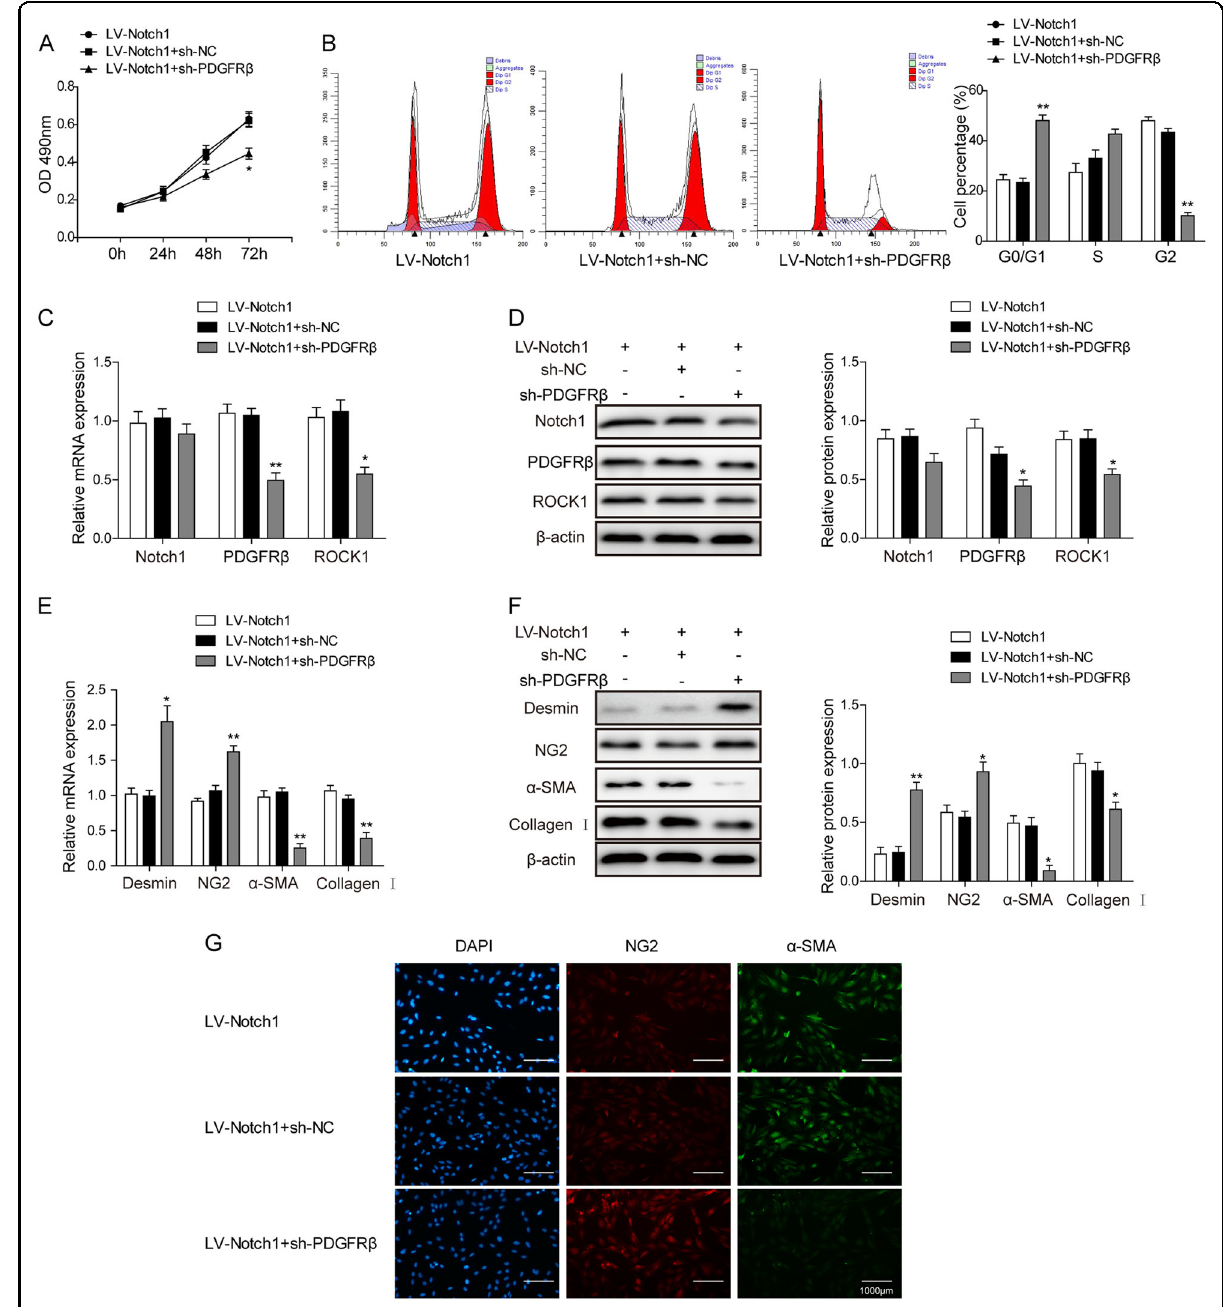
Fig. 3 PDGFR is involved in Notch1-mediated pericyte behaviors. a The MTT assay for cell viability after PDGFR β knockdown in LV-Notch1 cells (LV-Notch1 + sh-PDGFR β ) compared with that of the LV-Notch1 + sh-NC and LV-Notch1 groups. b Flow cytometry for cell cycle analysis of pericytes from LV-Notch1, LV-Notch1 + sh-NC, and LV-Notch1 + sh-PDGFR β groups. c Relative mRNA expression of Notch1, PDGFR β , and ROCK1 in the LV- Notch1, LV-Notch1 + sh-NC, and LV-Notch1 + sh-PDGFR β groups. d Western blot for Notch1, PDGFR β , and ROCK1 protein expression. e Relative mRNA levels for the pericyte differentiation marker genes. g Western blot analysis showing the protein levels of desmin, NG2, α -SMA, and collagen I in the LV-Notch1, LV-Notch1 + sh-NC, and LV-Notch1 + sh-PDGFR β groups. f Immuno fl uorescent staining for cell surface markers indicating pericyte differentiation. The means ± SD in the graph present the relative levels from three replicates. * p <